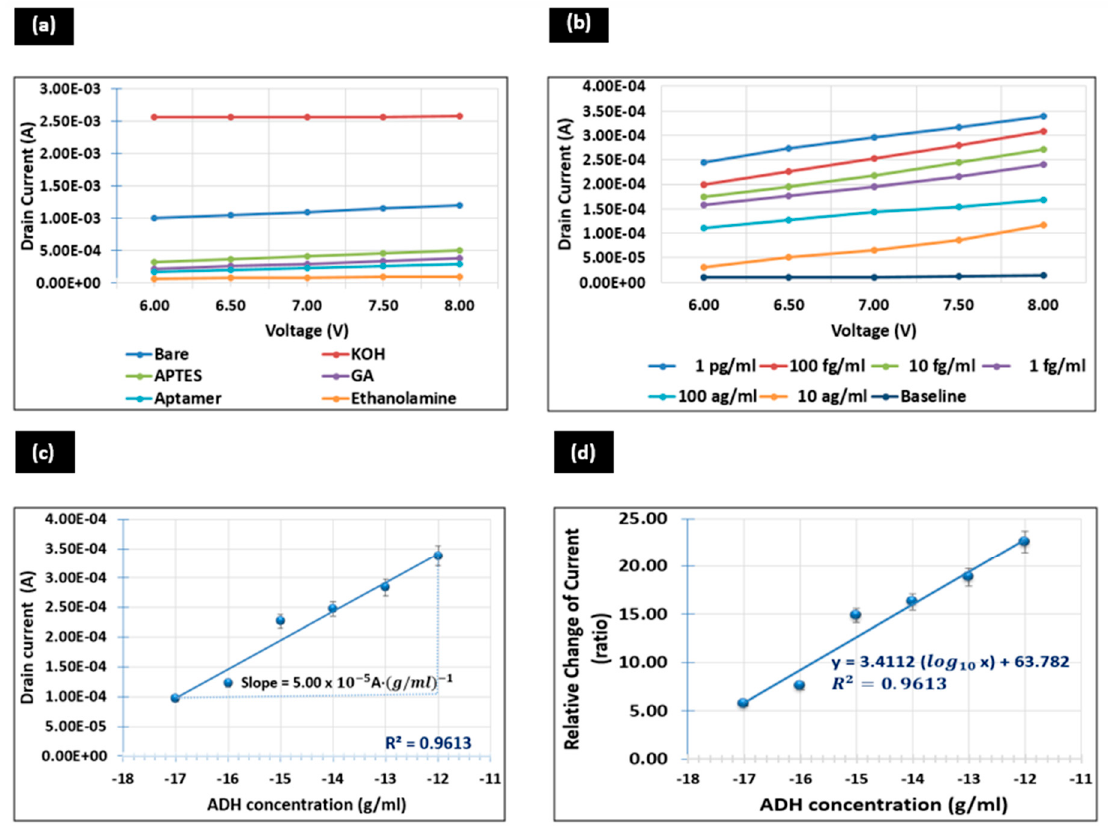
Figure 5. The current to voltage (I–V) measurements. ( a ) prior to surface functionalization; ( b ) for various ADH concentrations; ( c ) sensitivity and ( d ) limit-of-detection.